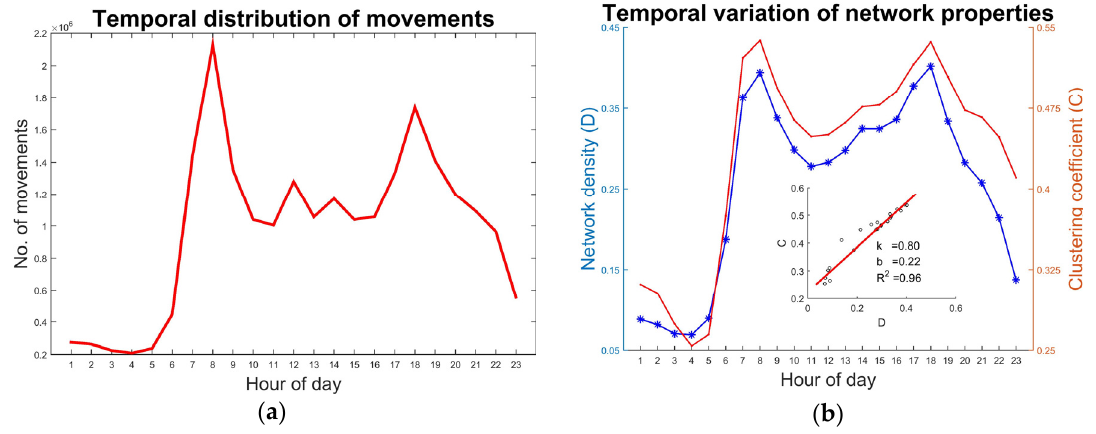
Figure 3. Temporal distribution of: ( a ) movements; and ( b ) basic network properties.